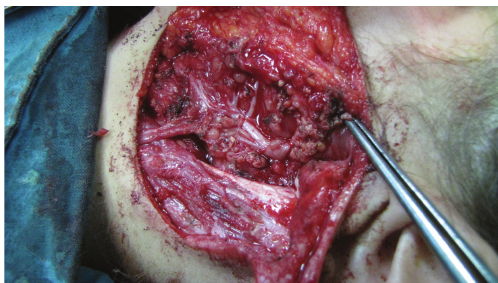
Figure 3: Superficial parotidectomy with complete excision of the cyst. Branches of the facial nerve exposed after performing a superficial parotidectomy.